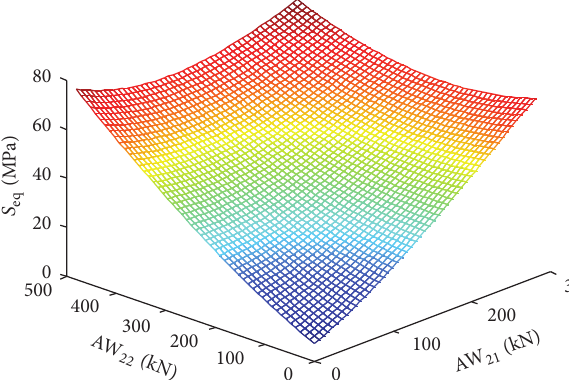
Figure 9: Response surface of the 2-axle